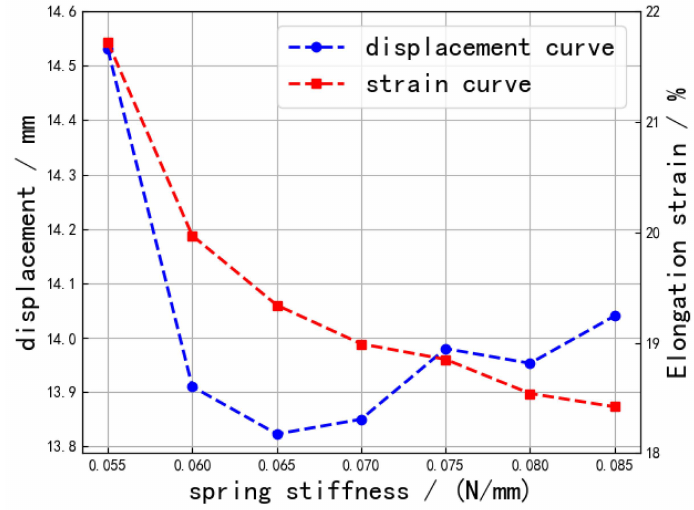
Figure 13. Single-degree-of-freedom simulation of the elongation displacement/strain–spring stiff- ness curve of the drive unit.